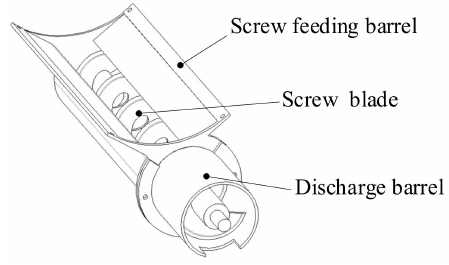
Figure 23. Screw effect analogy